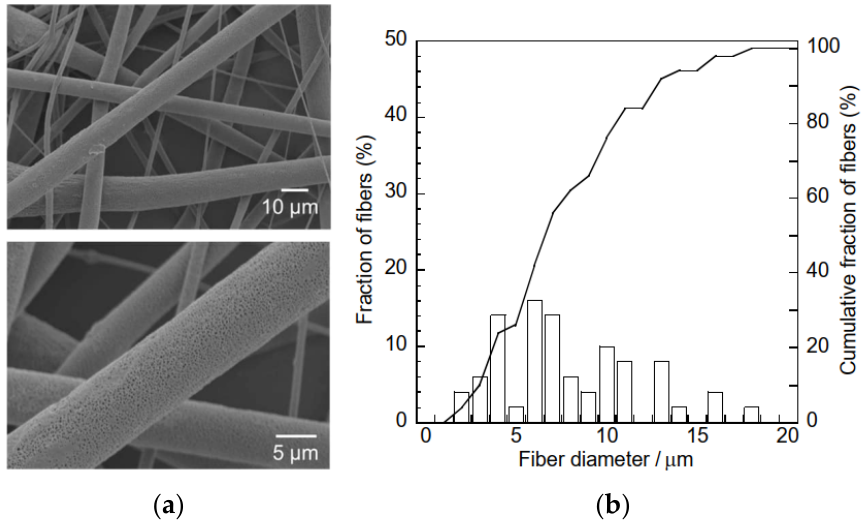
Figure 8. ( a ) SEM micrographs and ( b ) fiber size distribution curves of the composite sample consisting of porous fibers.